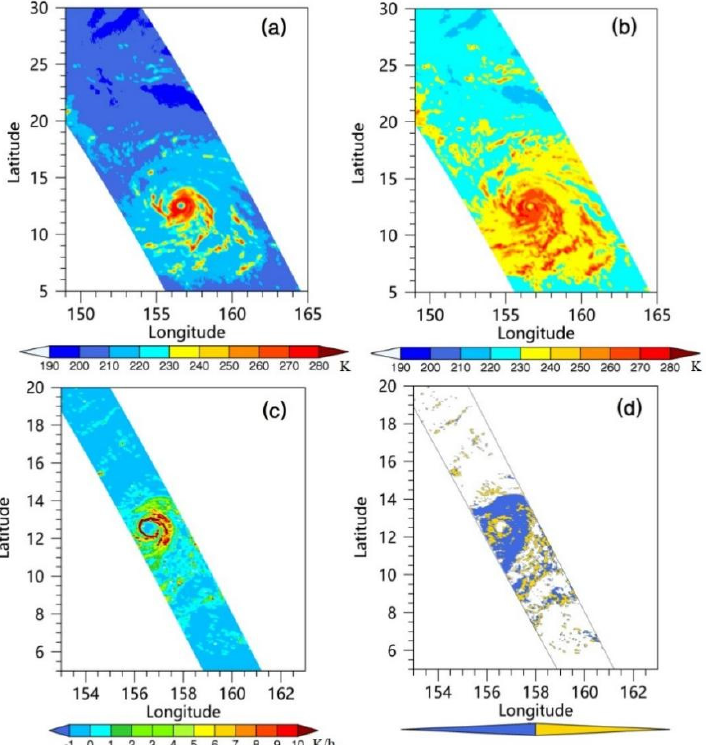
Figure 4. Brightness temperature distributions of 17:00 on 6 July at ( a ) 18.7 GHz and ( b ) 89.0 GHz channels of the GMI (K), ( c ) the latent heating distribution obtained by the GPM spectral latent heating (K h − 1 ) and ( d ) precipitation classification (blue: stratiform precipitation; yellow: convective precipitation).